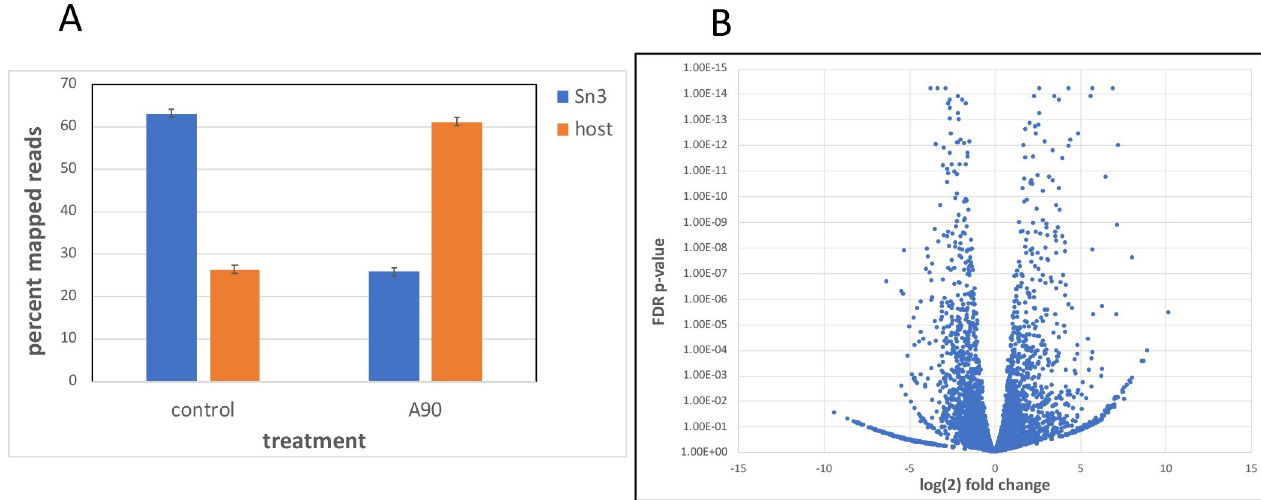
Fig 3. Gene expression in control and AN3661-treated cells. A. Overall parasite and host expression in control and AN3661-treated cells. The percent of all reads that map to the S . neurona and B . taurus genomes was calculated and plotted as shown. “control”–infected cells grown in the absence of AN3661. “A90”– infected cells treated with 90 nM AN3661. Reads mapping to the parasite genome are summarized with blue bars, and those mapping to the host cell genome with orange bars. Error bars denote standard deviations calculated from the values in each replicate of the respective sample. B. Volcano plot depicting changes in S . neurona gene expression due to AN3661